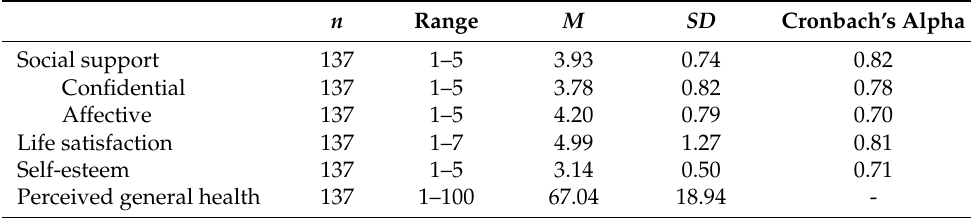
Table 1. Descriptive statistics of the variables used in the